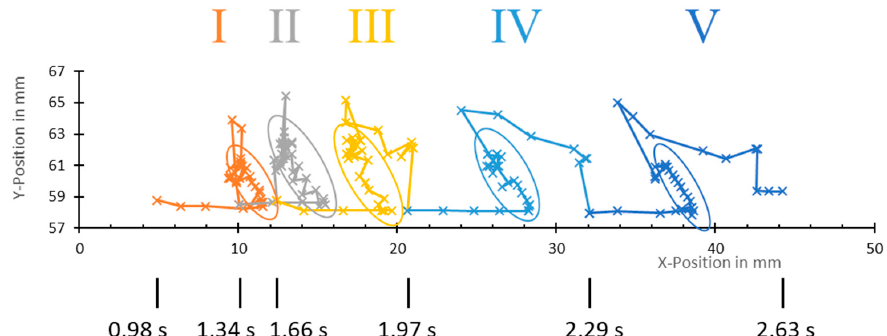
Figure 7. Movement pattern of five consecutive scraping cycles (numbering cf. Figure 6). Data points were acquired every 0.01 s. Time stamps refer to Figure 6. Encircled parts represent the scraping stroke.